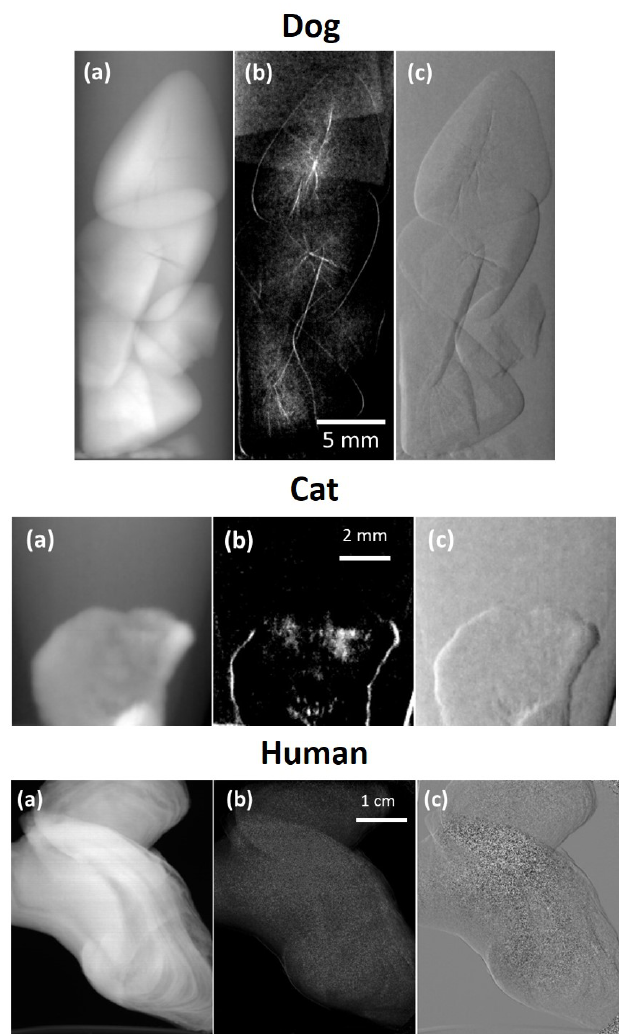
Figure 5. Retrieved ( a ) attenuation, ( b ) differential phase, and ( c ) dark-field images of three urinary stone samples taken by GI on the Talbot–Lau